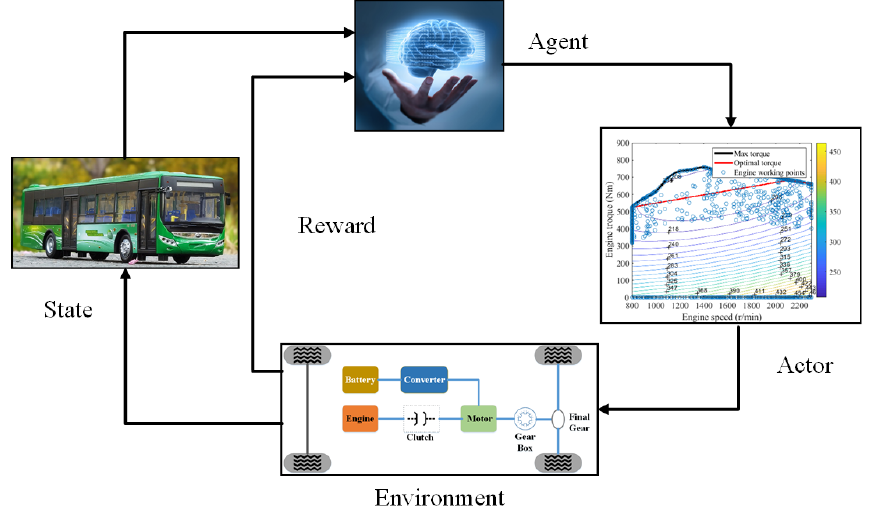
Figure 5. Agent-Environment